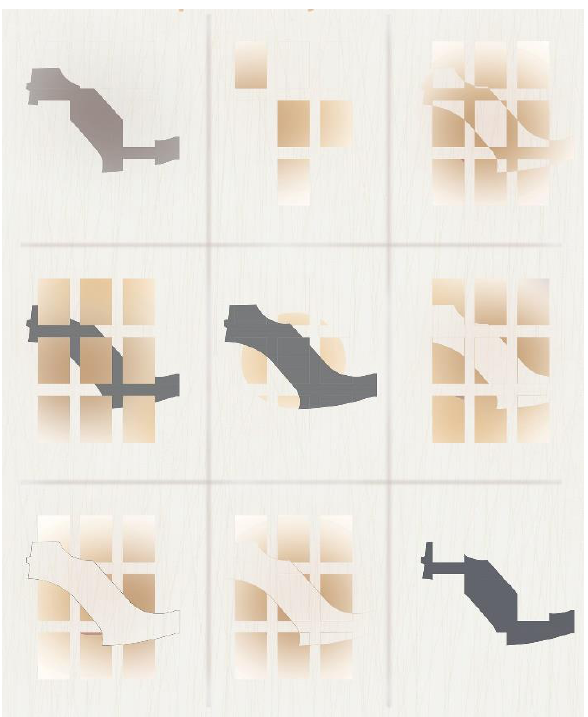
Figure 8. Fernando Martinez Sanabria, Residenza Giraldo (1958), Bogotà. Project conceptualization starting from the architecture’